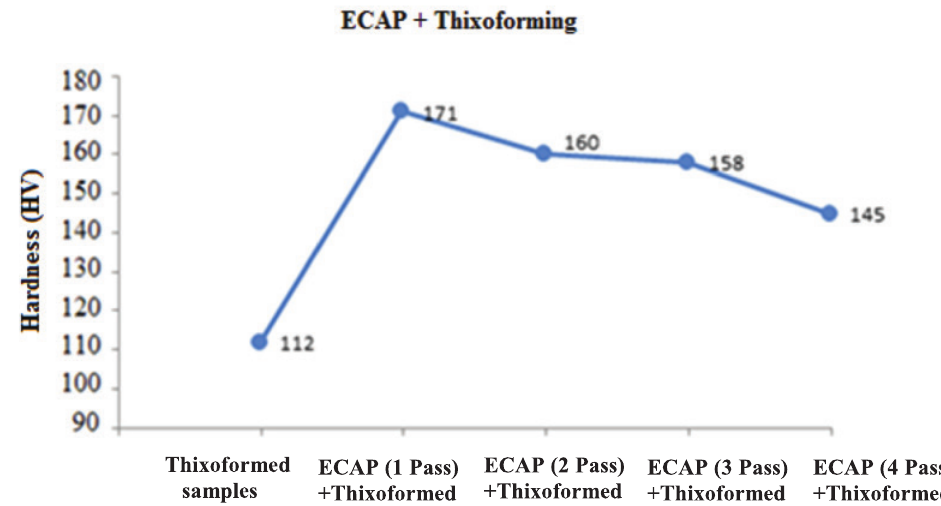
Fig. 6: Vickers hardness of thixoformed, ECAP’ed and thixoformed AA7075